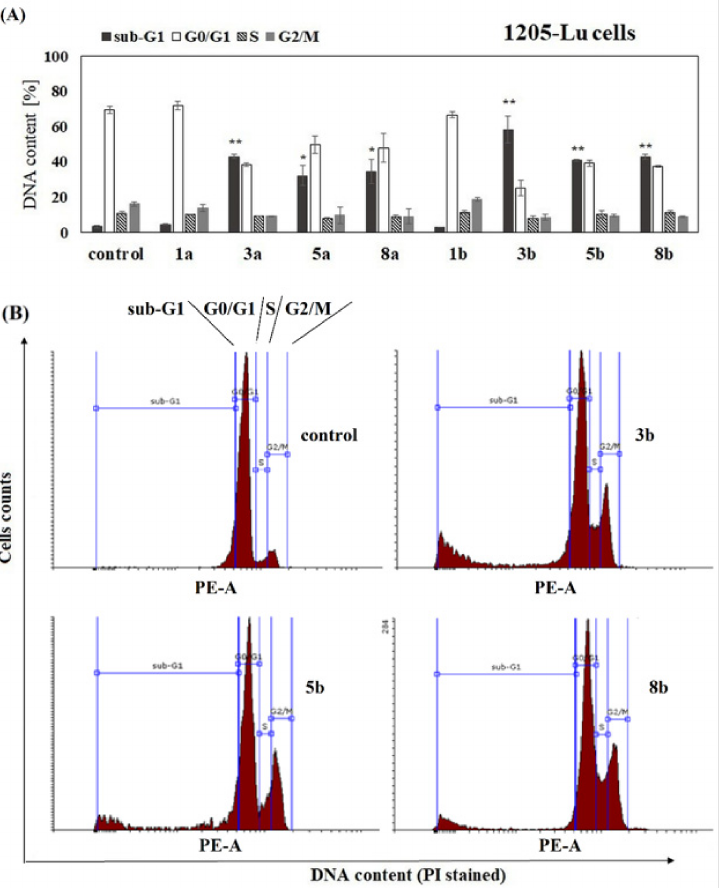
Figure 3. The distribution of 1205-Lu cells in major phases of the cycle. Cells were cultured for 72 h in the presence of the studied chemicals at a concentration of 100 µ M. The statistical significance was determined (* p < 0.05 and ** p < 0.001) ( A ). Representative histograms for effects obtained in 1205-Lu cell line are shown ( B